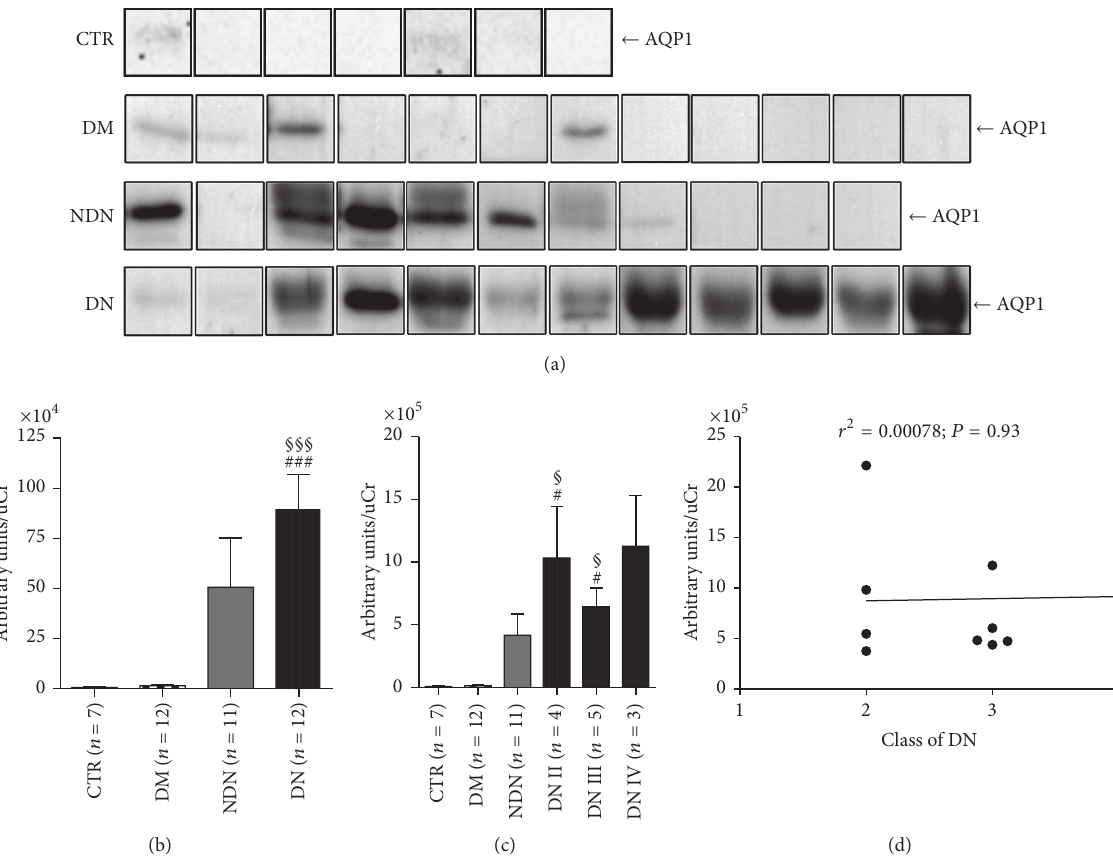
Figure 4: The urinary excretion of AQP1 increases in both DN and NDN patients and does not correlate with the clinical severity of DN. (a) Exosomes were isolated from urine of healthy subjects (CTR, 𝑛 = 7 ), patients with DM ( 𝑛 = 12 ), patients with NDN ( 𝑛 = 11 ), and patients with DN ( 𝑛 = 12 ) using the two-step differential centrifugation method. Total exosome proteins were resolved on 12% SDS-PAGE and analyzed by Western blotting for AQP1 abundance. (b) Densitometry analysis of the uAQP1 band intensities was normalized for uCr and reported as means ± SEM. §§§ 𝑃 < 0.001 versus CTR and ### 𝑃 < 0.001 versus DM, obtained by Kruskal-Wallis one-way ANOVA test. (c) DN patients were grouped according to the histological changes evaluated by kidney biopsy: DN stage II ( 𝑛 = 4 ), DN stage III ( 𝑛 = 5 ), and DN stage IV ( 𝑛 = 3 ) and densitometry analysis of uAQP1 at each stage compared to uAQP1 in CTR and DM and NDN patients. All data are reported as mean ± SEM. § 𝑃 < 0.05 versus CTR and # 𝑃 < 0.05 versus DM, obtained by Kruskal-Wallis one-way ANOVA test. (d) Linear regression analysis of uAQP1 abundance, as semiquantified by Western blotting, with the class of DN ( 𝑟 2 = 0.00078 ; 𝑃 = 0.93 ).